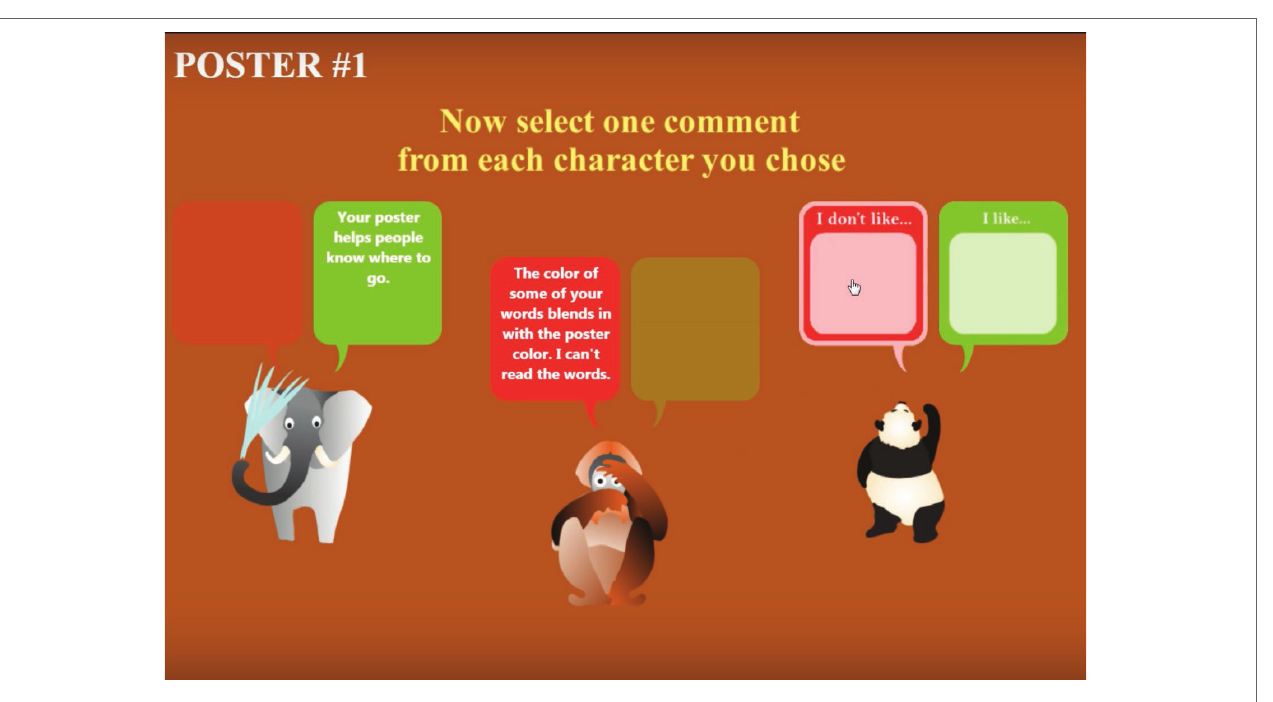
FIGURE 2 | In the Choose condition, players choose either critical or confirmatory feedback from each